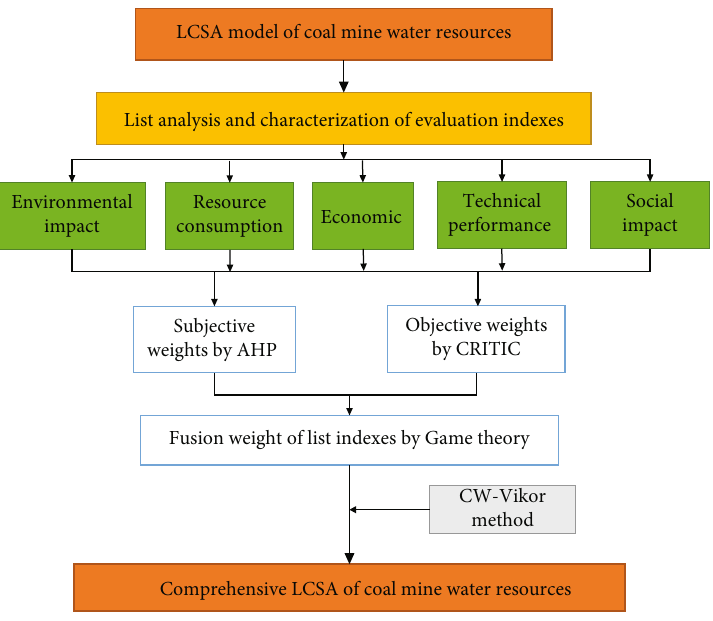
Figure 2: Methodology fl ow Table 1: Classi fi cation of environmental impacts and sources of pollutants.